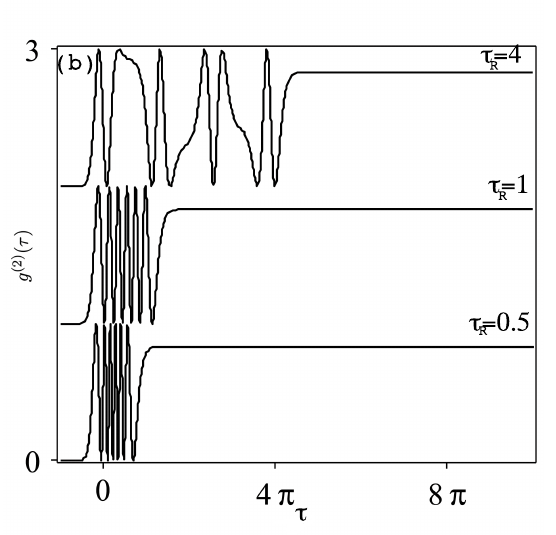
Figure 5. ( a ) As Figure 4 but for n = 4 pulse , Ω 1 = 0.5 and for different values of τ R . ( b ) As ( a ) but with Ω 1 =